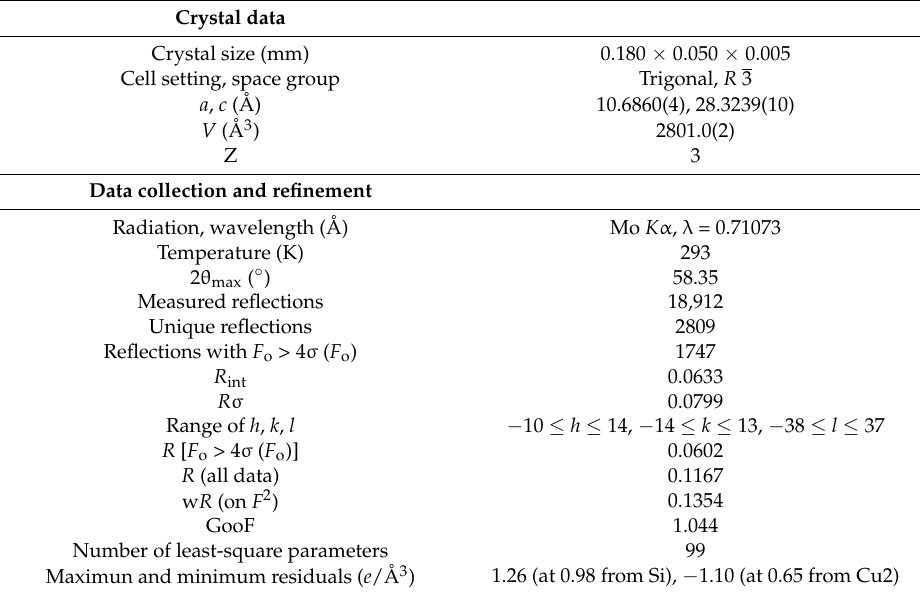
Table 3. Crystal and experimental details for